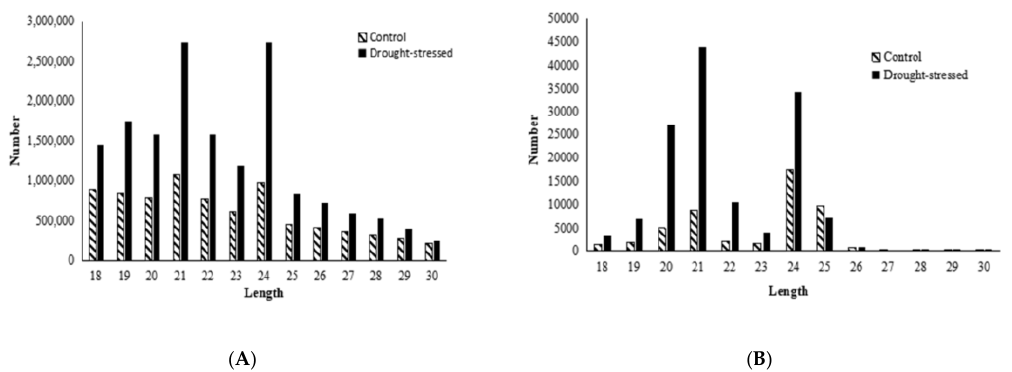
Figure 1. Size distribution of Clean reads ( A ) and miRNA ( B ) of control and drought stress in A. mongolicum .